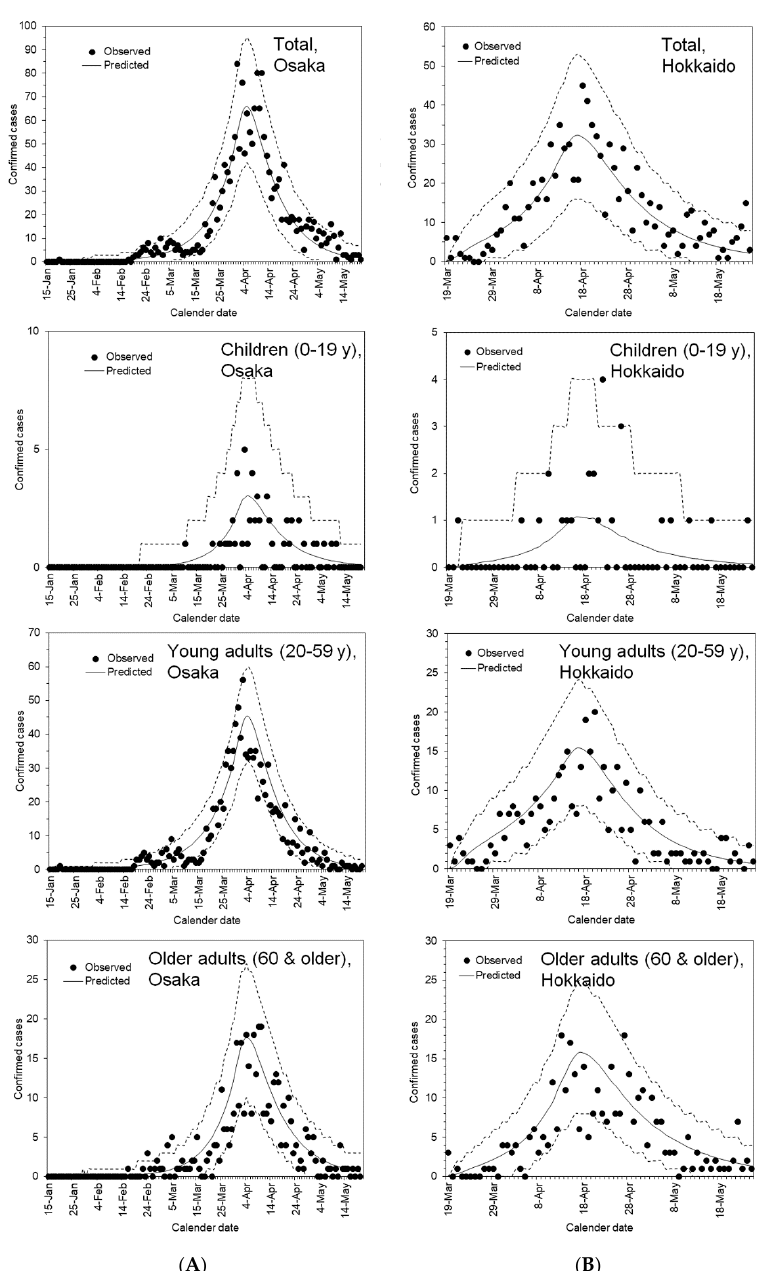
Figure 1. Comparison between the observed and predicted incidence of COVID-19 in Osaka and Hokkaido, 2020. Dots represent the observed incidence by the date of illness onset, whereas the solid line represents the fitted curves using maximum likelihood estimation and the dashed lines represent the 95% credible intervals derived from the parametric bootstrapping method; ( A ) Osaka Prefecture and ( B ) Hokkaido. Hokkaido was ahead of other prefectures in experiencing the first wave from early